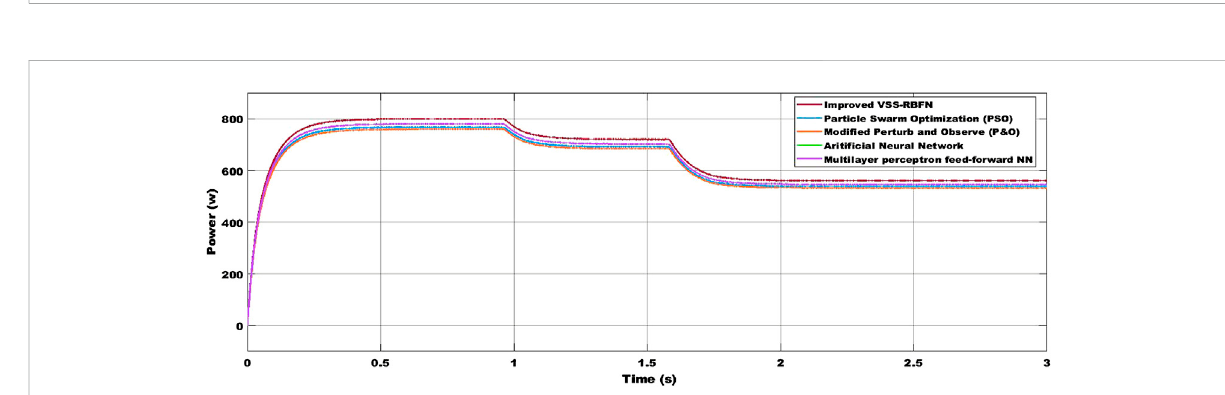
FIGURE 5 (A) At 1,000 W/m 2 , output power from various MPPT approaches. (B) At 1,000, 900, and 700 W/m 2 , various MPPT approaches are used to generateoutputpower. (C) At1,000 and700 W/m 2 ,respectively,theoutputpowerisobtainedusingvariousMPPTapproaches. (D) VSS-RBFA-based MPPT topology is utilized to calculate the output power of converters under uniform irradiation.